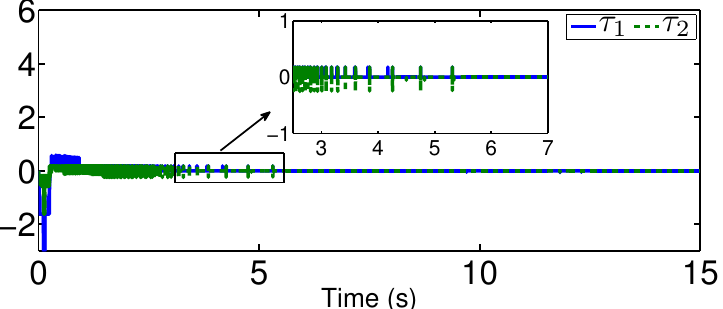
Figure 7. Control trajectory τ under the proposed controller.